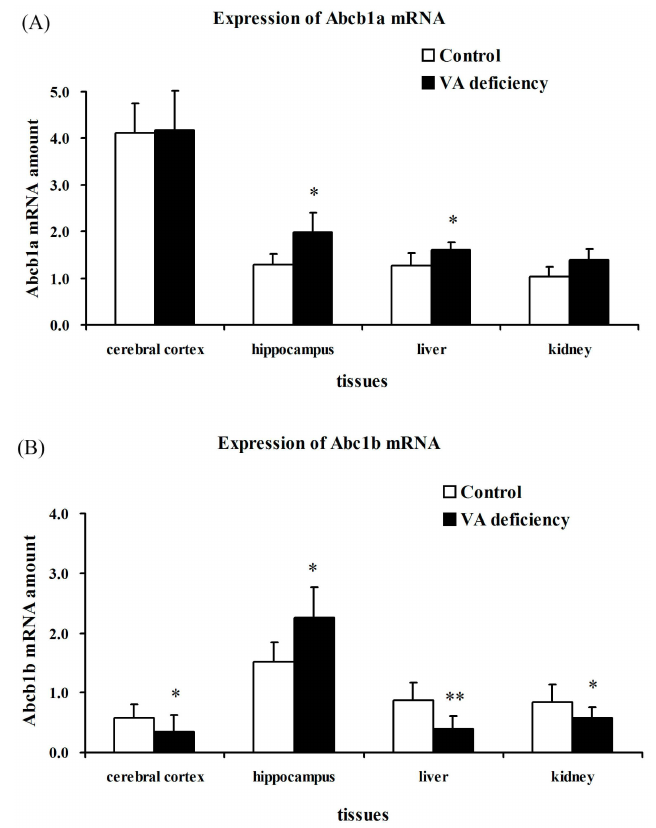
Figure 1. Effects of vitamin A (VA) deficiency on Abcb1a/1b mRNA levels in cerebral cortex, hippocampus, liver and kidney of experimental rats. Relative stain intensity for Abcb1a mRNA levels ( A ) and Abcb1b mRNA levels ( B ) in indicated tissues of experimental rats are presented. qRT-PCR was used to measure levels of Abcb1a/1b mRNA in indicated tissues, and each datum represents the mean ˘ SD of four rats. * p < 0.05; ** p < 0.01 vs. control values using ANOVA statistics followed by